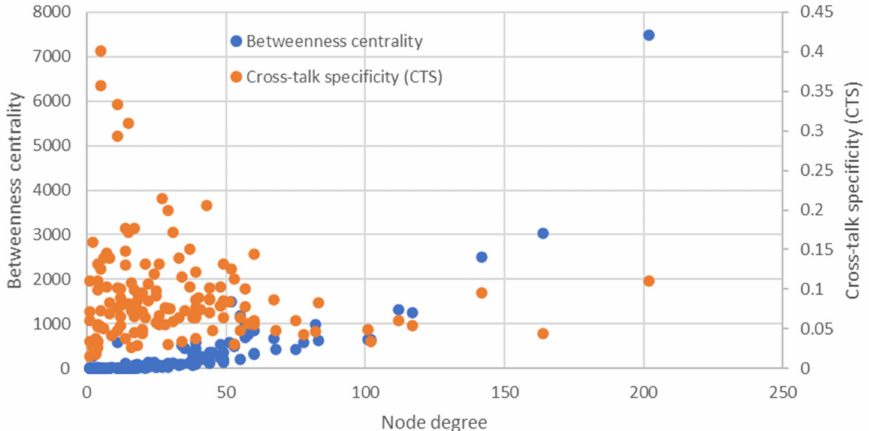
Figure 2. The distribution of node connectivity, betweenness centrality and cross-talk specificity (CTS) values in the hypoglycemia